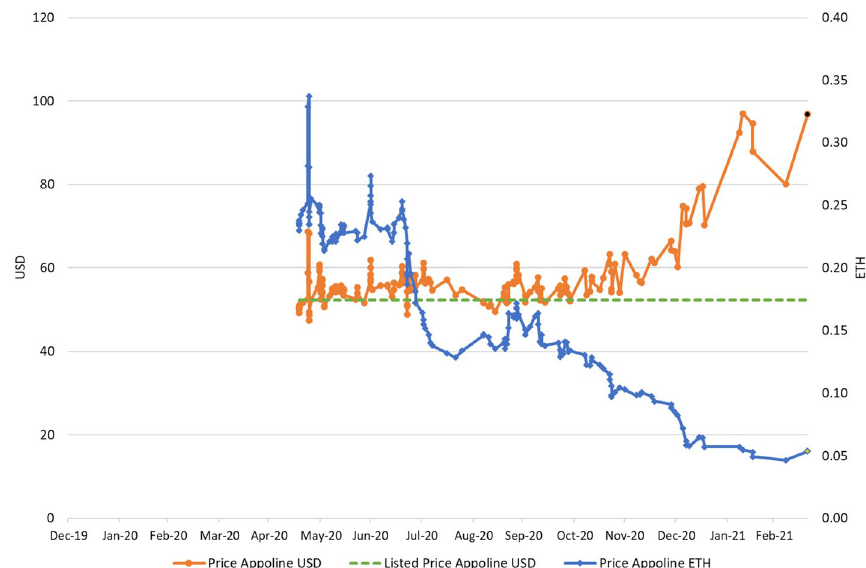
Fig. 17 Price (in USD and ETH) of 18,276 Appoline Street Detroit MI. Each dot represents one transaction. Last colored dot is ask price on